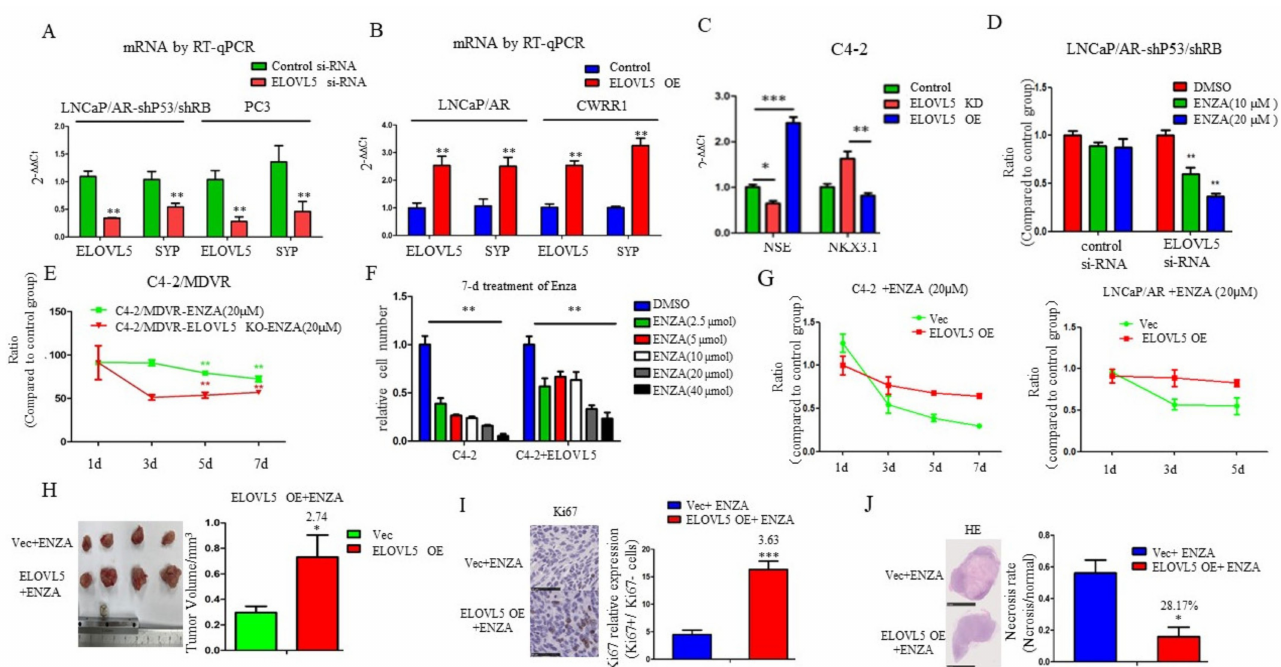
Figure 3. ELOVL5 regulates enzalutamide sensitivity and resistance of prostate cancer cells. ( A ). Changes of ELOVL5 and SYP mRNA level in NE-like PCa cells (LNCaP/AR-shP53/shRB and PC3) with the ELOVL5 knockdown by siRNA. ( B ). Changes of ELOLV5 and SYP mRNA level in adenocarcinoma PCa cells (LNCaP/AR and CWRR1) with the ELOVL5 overexpression. ( C ). Changes of NSE and NKX3.1 mRNA levels in C4-2 cells with ELOVL5 knockout by CRISPR-Cas9 or ELOVL5 overexpression. ( D ). Survival rate of LNCaP/AR-shP53/shRB with ELOVL5 knockdown by siRNA after 7-day enzalutamide treatment at different doses. ( E ). Cell growth curves of C4-2/MDVR and C4-2/MDVR-ELOVL5